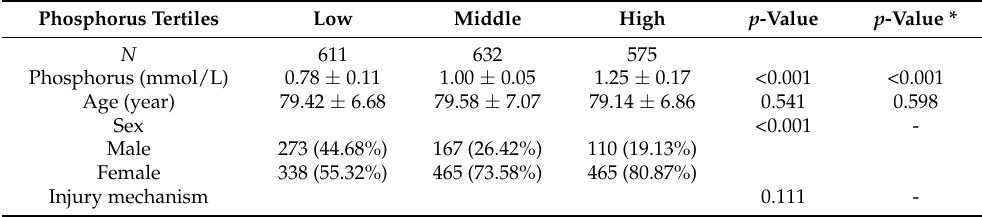
Table 1. The demographic and clinical